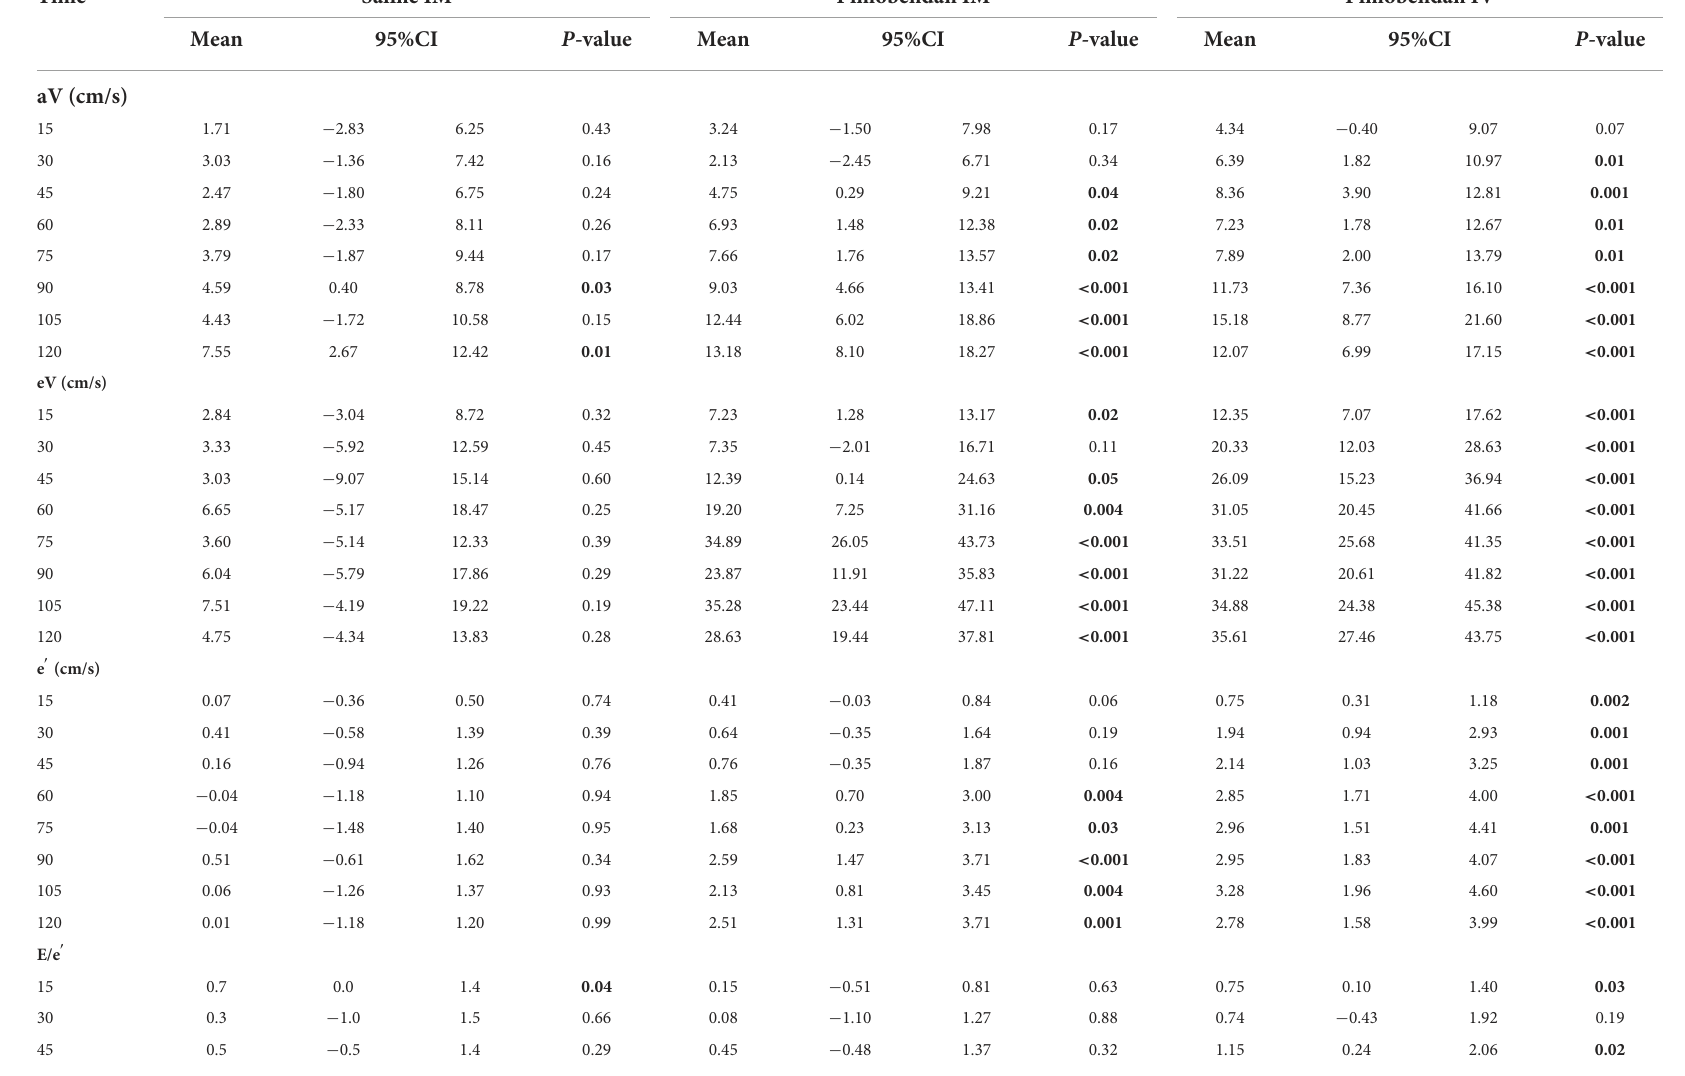
TABLE 2 Hemodynamic parameters after pimobendan injection in comparison with the baseline (Time 0). Time Saline IM Pimobendan